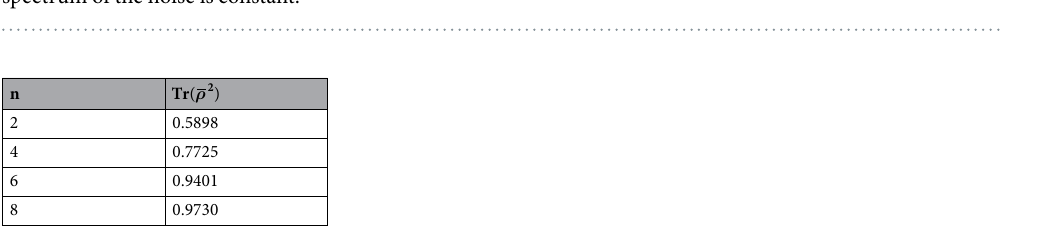
Table 2. The relation between the coherence ratio and the chain length n for the constructed control gate. The spectrum of the noise is 1/| ω |.  = 10000 , J = 1. ω l and ω h are set to 0.001 and 0.003,